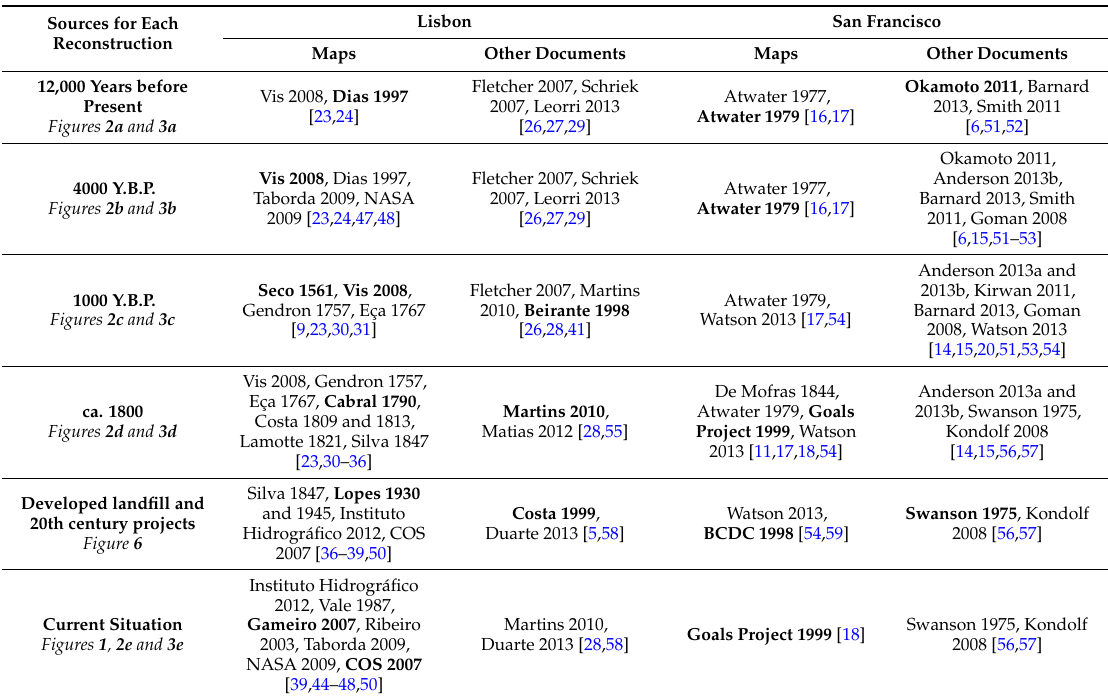
Table 2. Sources used for the reconstruction of environmental histories. Main sources for each reconstruction highlighted in bold , corresponding maps indicated in